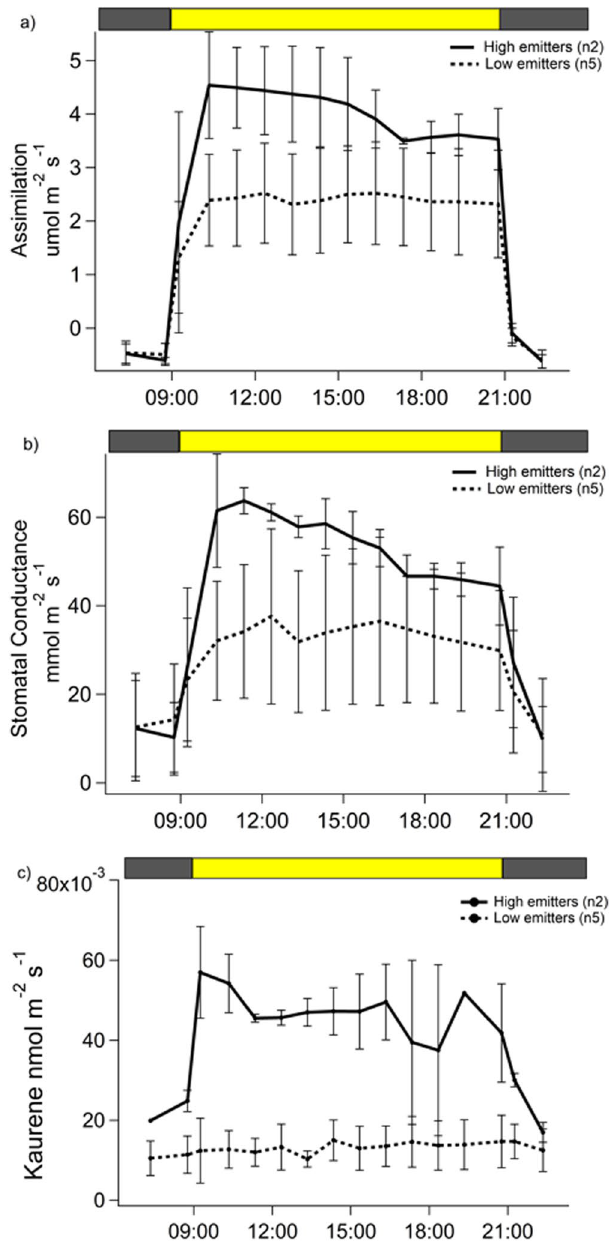
Figure 1. Diurnal cycles of kaurene emission rates ( a ) CO 2 assimilation rate ( b ) and stomatal conductance ( c ) by seven individuals of H . halimifolium . The thick line represents the high emitter group (n = 2) and the dashed line represents the low emitter group (n = 5). Error bars indicate one standard deviation. The top bar indicates the light (yellow) and dark (grey)